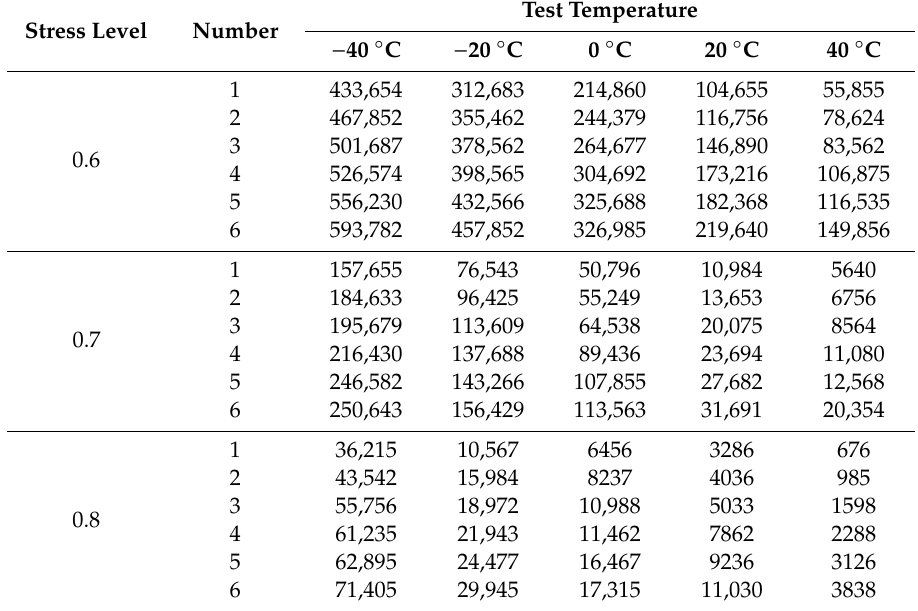
Table 9. Fatigue life test results